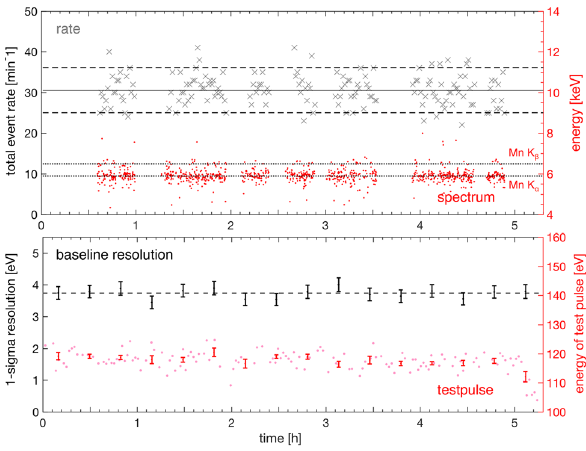
Fig. 5 Stability of the prototype detector over the measuring time of 5.31hafterthestabilitycut.Lefty-axis:Totalnumberofcountsacquired per minute. Within statistics (dashed lines give Poissonian variance) the rate is stable over the entire run at a mean of 0.51Hz (solid line). Right y-axis: Red dots show all events observed in the energy region of 4– 8keV. The positions of the K α and K β X-ray energies (literature values) are indicated by dotted lines which are in agreement with the data. This demonstrates the stability of the detector response over time